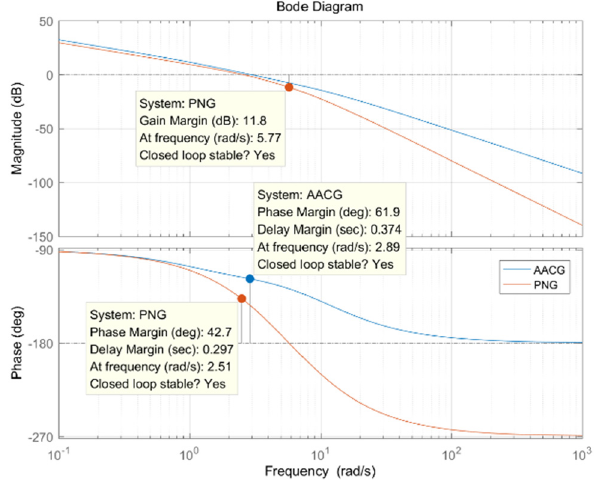
Figure 9: Unit step response of closed - loop system Φ * ( s ) .